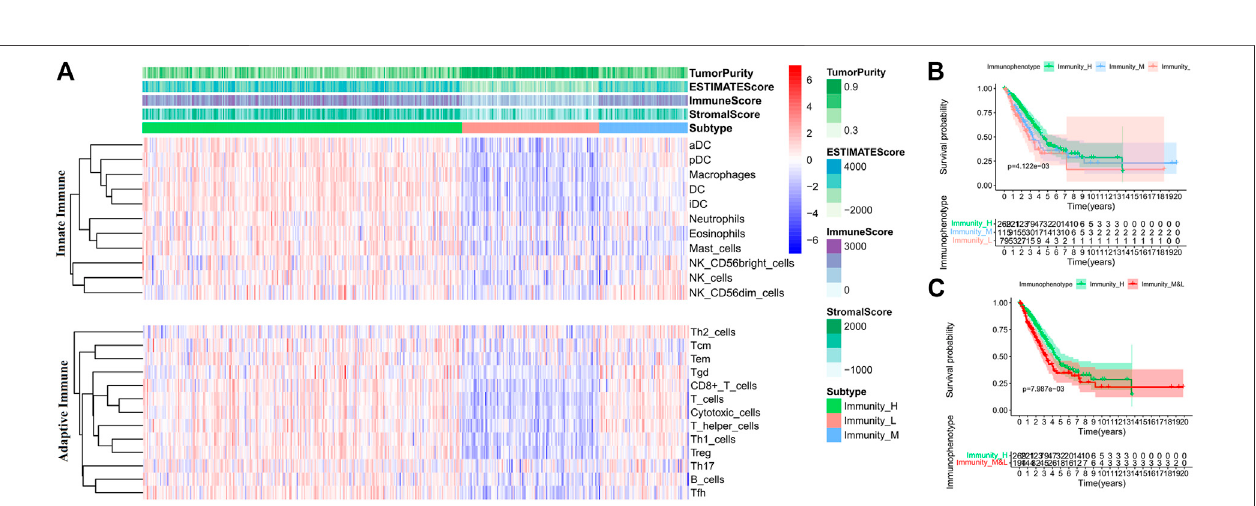
Figure S2B ). According to the immune scores, three clusters